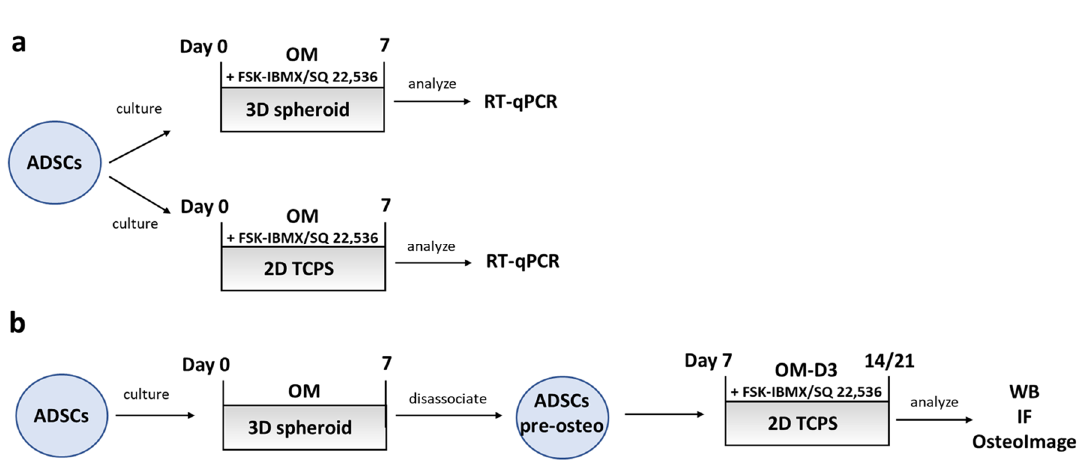
Figure 5. Early- and late-osteogenesis experiment procedures. Experiment setup for studying early and late osteogenesis of adipose-derived mesenchymal stem cells (ADSCs). ( a ) Early and ( b ) late osteogenesis.